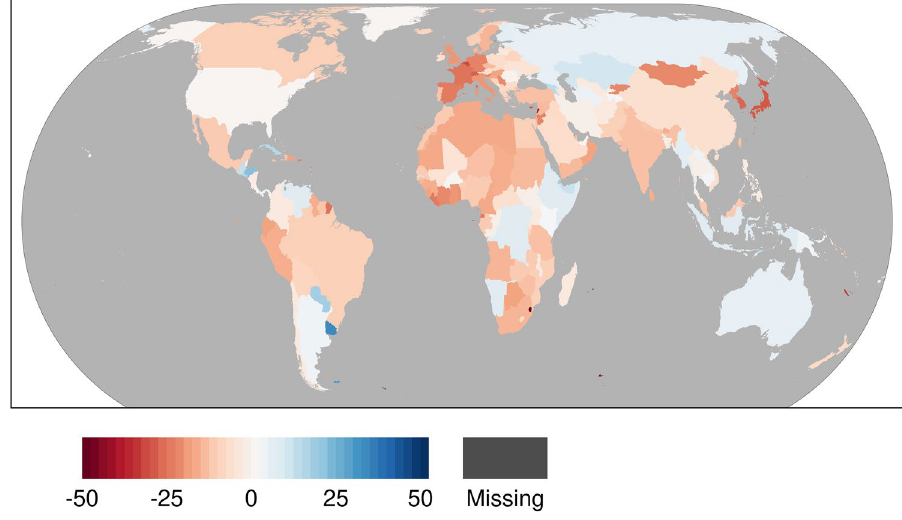
Fig. 4 Change rate of country- level monthly median NO